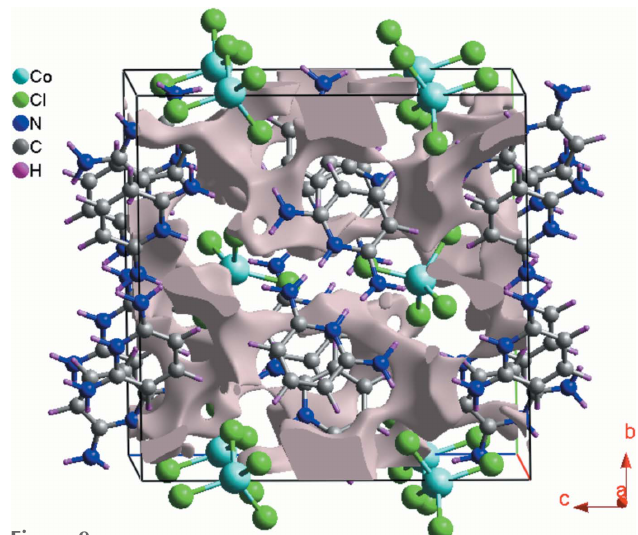
Figure 9 Void plot for